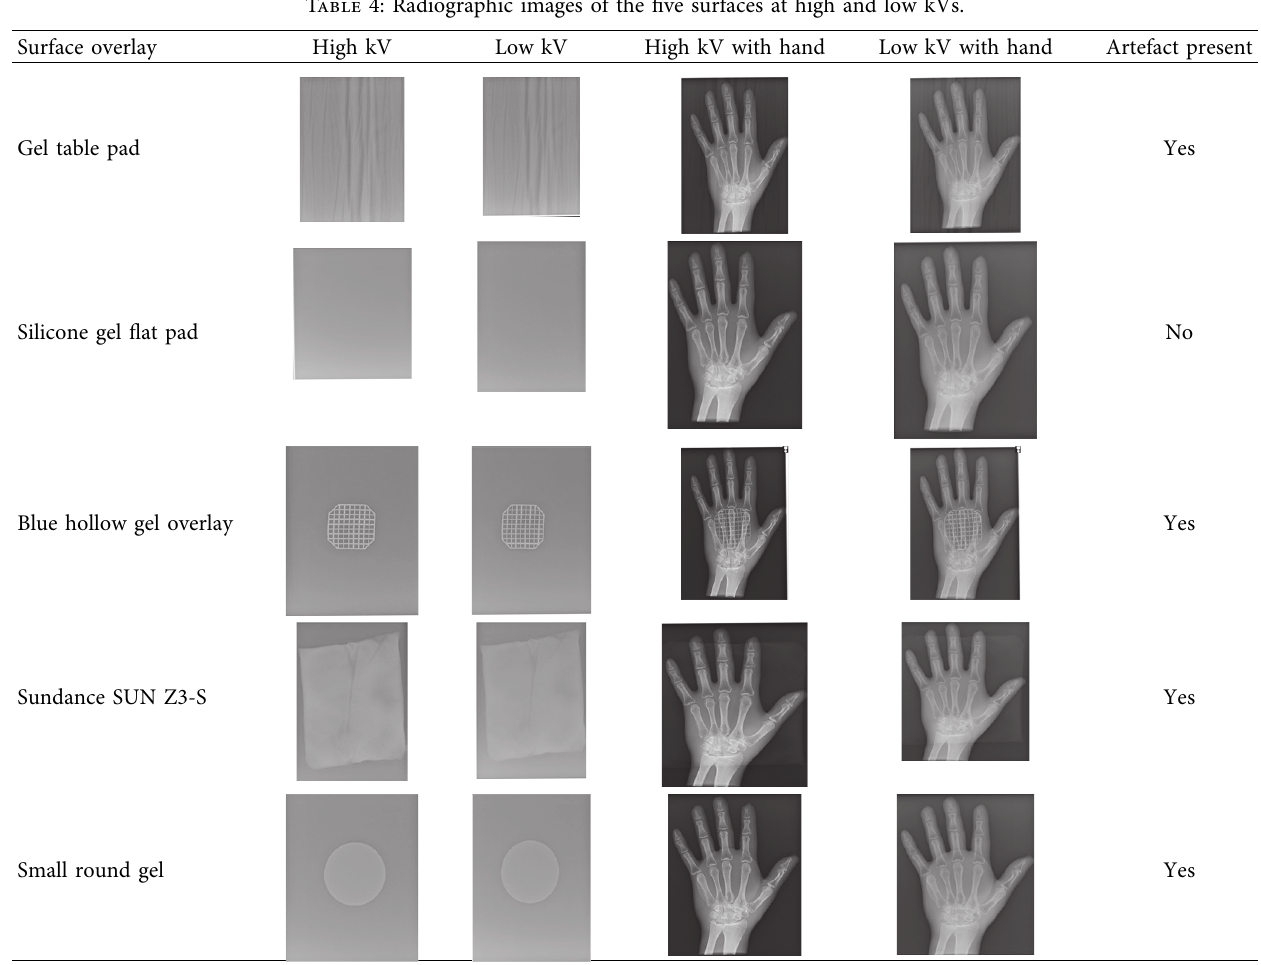
Table 4: Radiographic images of the five surfaces at high and low kVs. Surface overlay High kV High kV with hand Low kV with hand